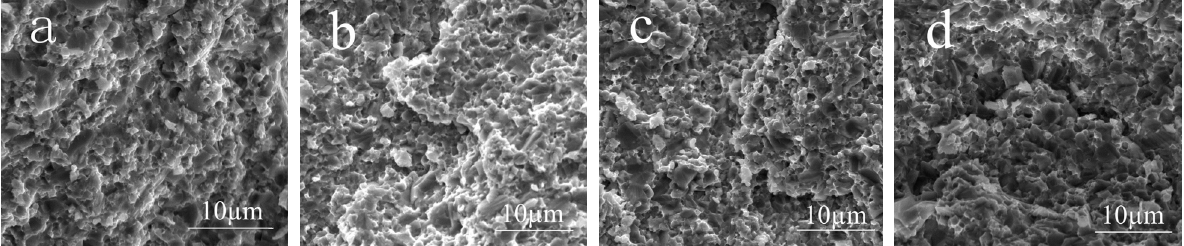
Fig. 4 Fracture surface of Ti(C,N)-based cermets with the MWCNT addition of: (a) 0.2 wt%, (b) 0.5 wt%, (c) 0.8 wt%, and (d) 2.0